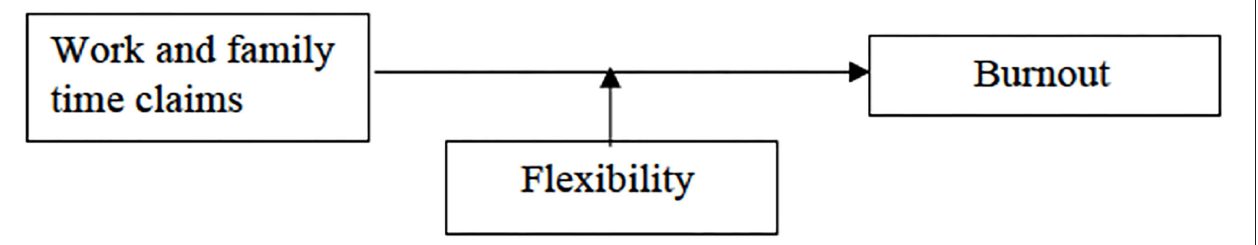
FIGURE 1 | The effect of work and family time claims on burnout and the moderating effect of